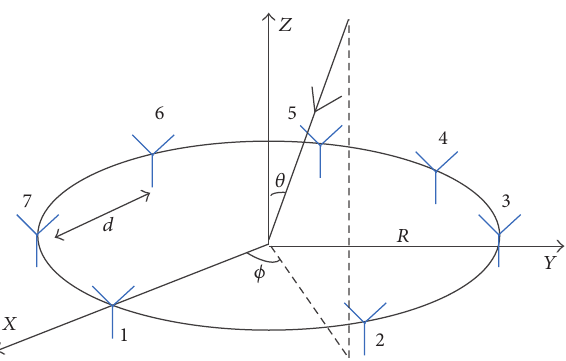
Figure 15: The seven-sensor uniform circular array geometry.